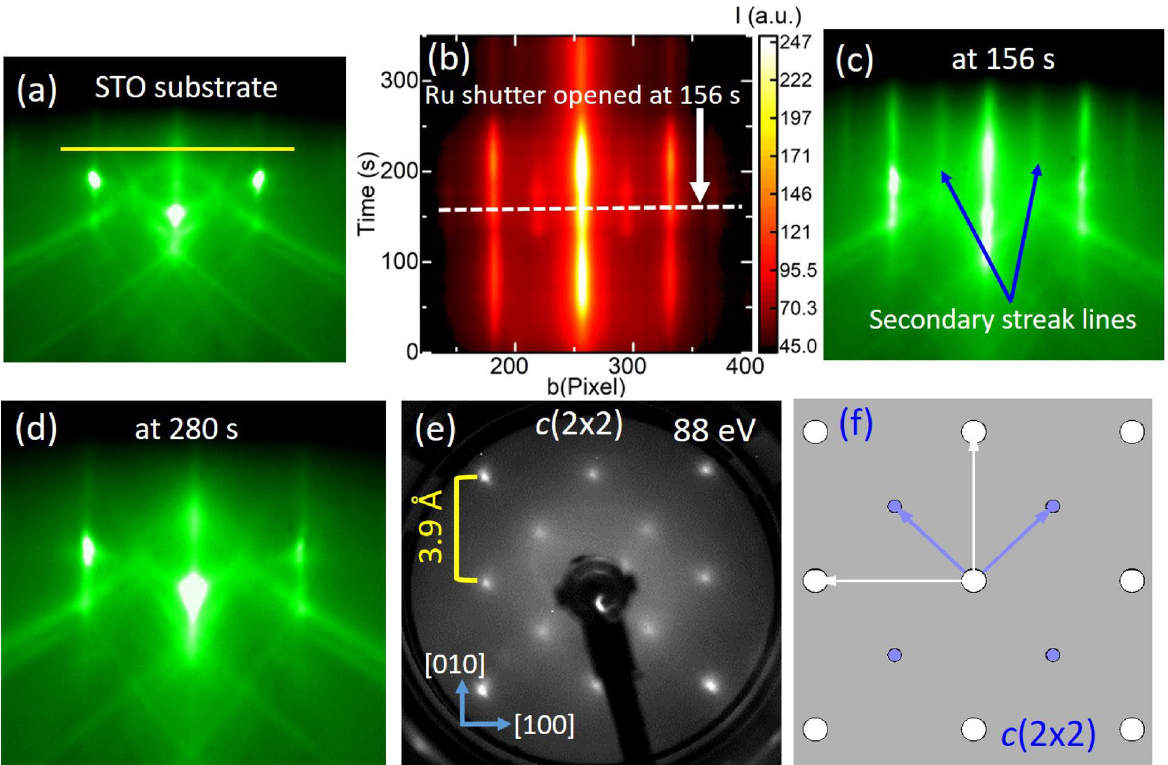
Figure 2. Structural evolution during the growth of SRO. ( a ) RHEED pattern of the TiO 2 -terminated STO (001) c substrate with electron beam along STO [110] c direction. ( b ) Time evolution of RHEED intensity along the yellow line shown in ( a ). After supplying Sr, the spot-like RHEED pattern from the STO substrate started to evolve into a streak-line pattern, and secondary streak-lines then appeared between the main streak lines. The white dashed line in ( b ) represents the optimum time for opening of Ru shutter, and the corresponding RHEED pattern is shown in ( c ), where the pronounced secondary streak-lines are observed. ( d ) The RHEED pattern after the growth of about 0.4 nm of SRO (at the time of 280 s), and its pattern and intensity remain nearly unchanged with subsequent SRO growth, indicating a step-flow type growth process. ( e ) shows the LEED pattern of an optimum initial SrO layer on STO substrate with a beam energy of 88 eV, which agrees well with the simulated LEED pattern shown in ( f ) with a c (2 × 2) Fig. 2d, indicating the structural transformation of the initial SrO layer due to the adsorption and incorporation of RuO x , and the RHEED pattern remained nearly unchanged after then. SRO films grown with the τ IGD < τ OIGD followed the island-type growth (see Supplementary Section 1). In contrast, for τ IGD > τ OIGD , the streak-line feature from the initial SrO layer remains nearly unchanged after opening the Ru shutter for subsequent growth of the SRO film as demonstrated in Supplementary Section 1. To further explore the surface structure prior the SRO growth, we grew a SrO layer on STO with τ IGD = τ OIGD at growth temperature of 700 o C. The secondary streak-lines were found to be stable while cooling down to room temperature, and then the sample was transferred under an ultra-high vacuum to a LEED chamber for surface structural characterizations. Figure 2e shows the LEED pattern with a beam energy of 88 eV. The primary spots come from the cubic STO substrate with a lattice spacing of 3.91 Å. The secondary spots appeared along the lateral <110> directions halfway between the main spots. The simulated LEED pattern 36 with a c (2 × 2) structure as shown in Fig. 2f exhibits a close agreement with the pattern we observed. These observations confirmed a c (2 × 2) superstructure on the surface of the initial SrO layer 37 . By using the same condition of τ IGD = τ OIGD , we grew a series of SRO( t ) films on STO with different t rang- ing from 1.2 to 28.5 nm. Figure 3a and b show the atomic force microscope (AFM) images before and after the growth of a t ≈ 9 nm film, respectively. The height profiles shown in the lower panel of Figs. 3a,b indicate the well preservation of atomic steps (height ≈ 0.4 nm) after the SRO film growth. The terrace width of the bare STO substrate was around 150 to 600 nm, which gives a miscut angle of around α ≈ 0.15 o to 0.04 o . Figure 3c shows the height-histogram of the shaded area in the Fig. 3a,b. The average surface roughness of around 0.12 nm after the growth remains nearly the same as that of the STO substrate. However, we did notice some well-separated random clusters on film surface (see Supplementary Section 2). From energy dispersive X-ray (EDX) analyses, we confirmed that those clusters were mainly composed of Ru 1 . Those random Ru clusters on the film surface are likely coming from the excess Ru during the growth. The density of the Ru clusters can be minimized by reducing the fluxes of both Sr and Ru, while keeping the same flux ratio (see Supplementary Section 2). Those Ru